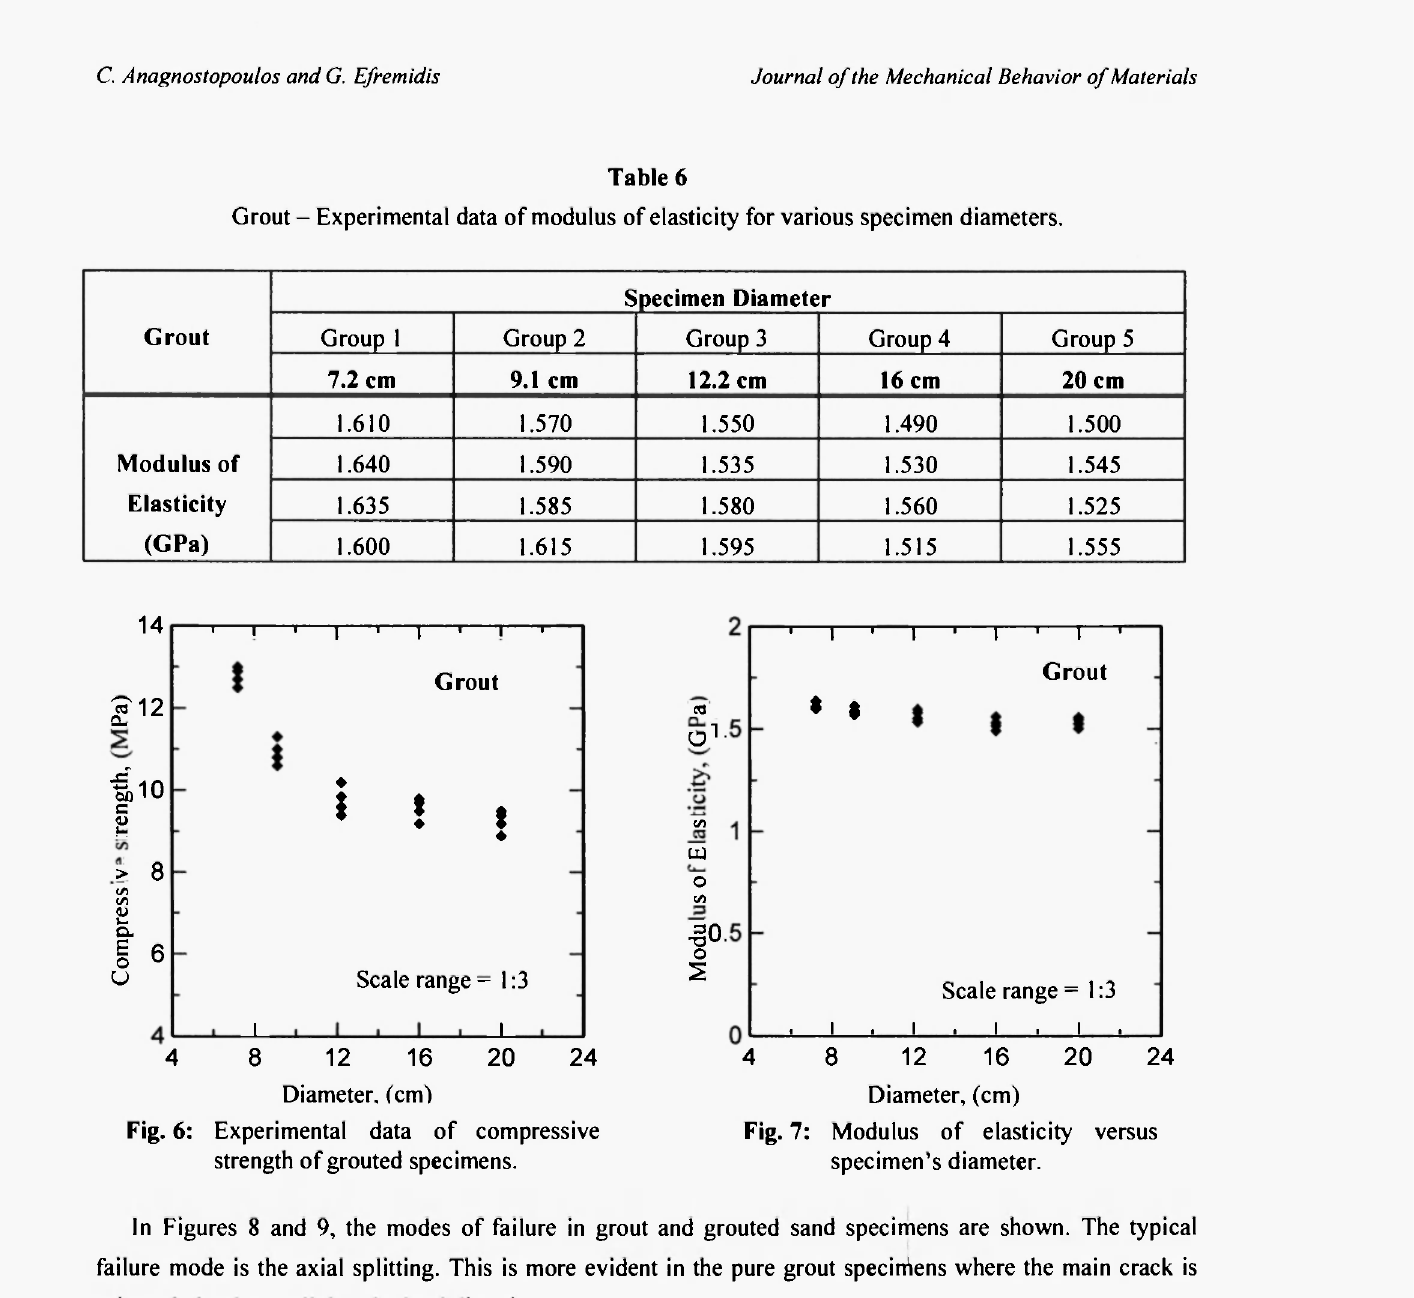
Fig. 7: Modulus of elasticity versus specimen's diameter.